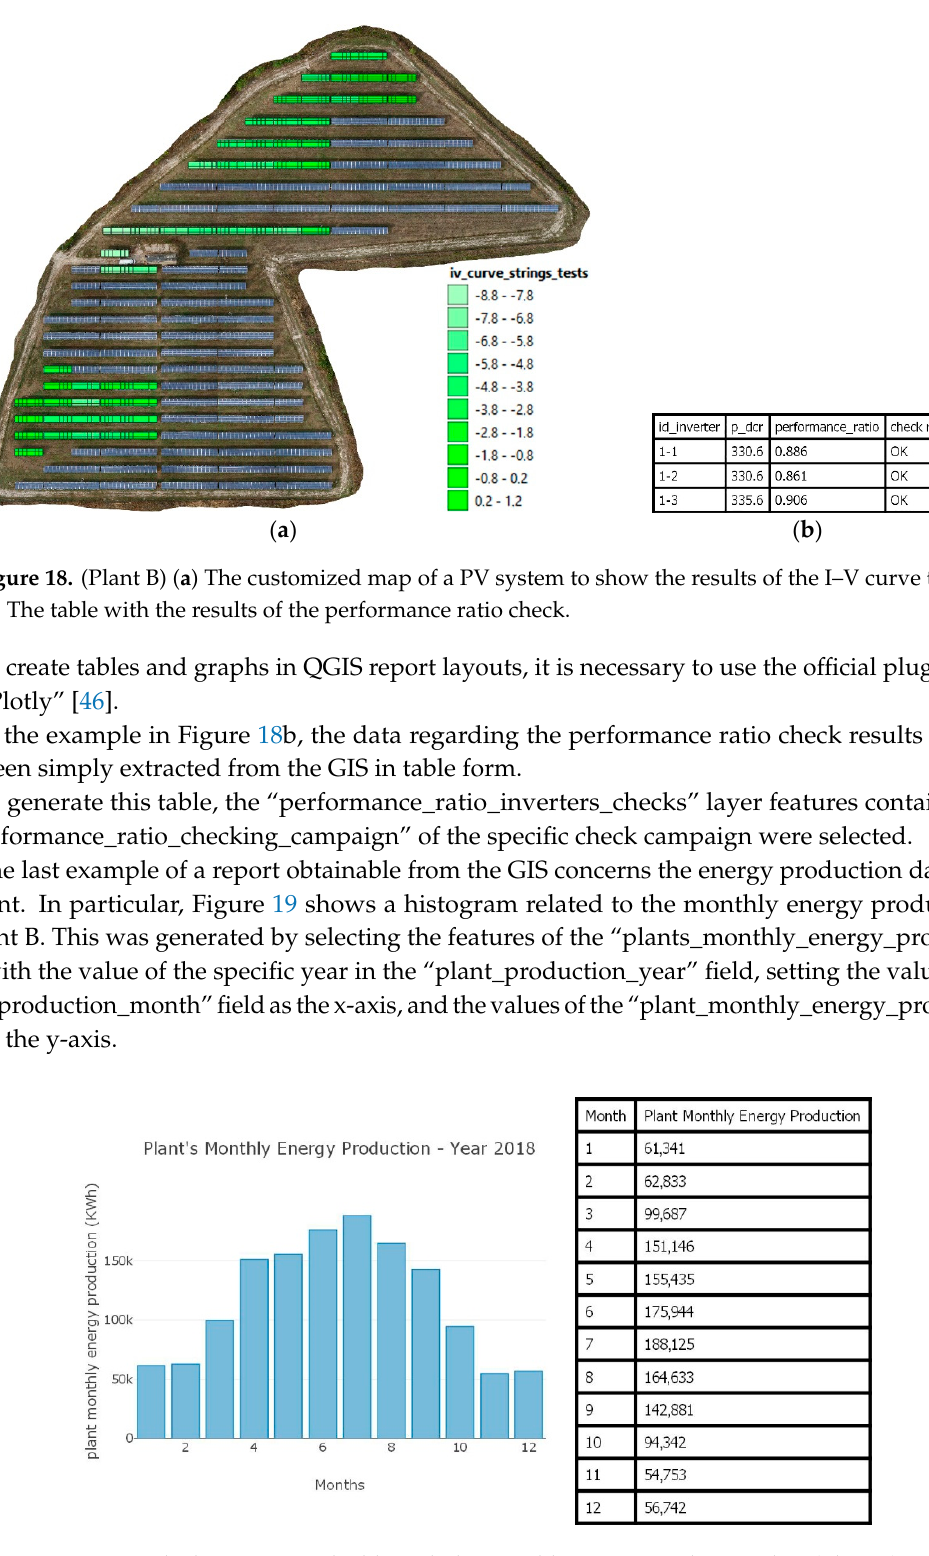
Figure 19. The histogram and table with the monthly energy production data (Plant B).